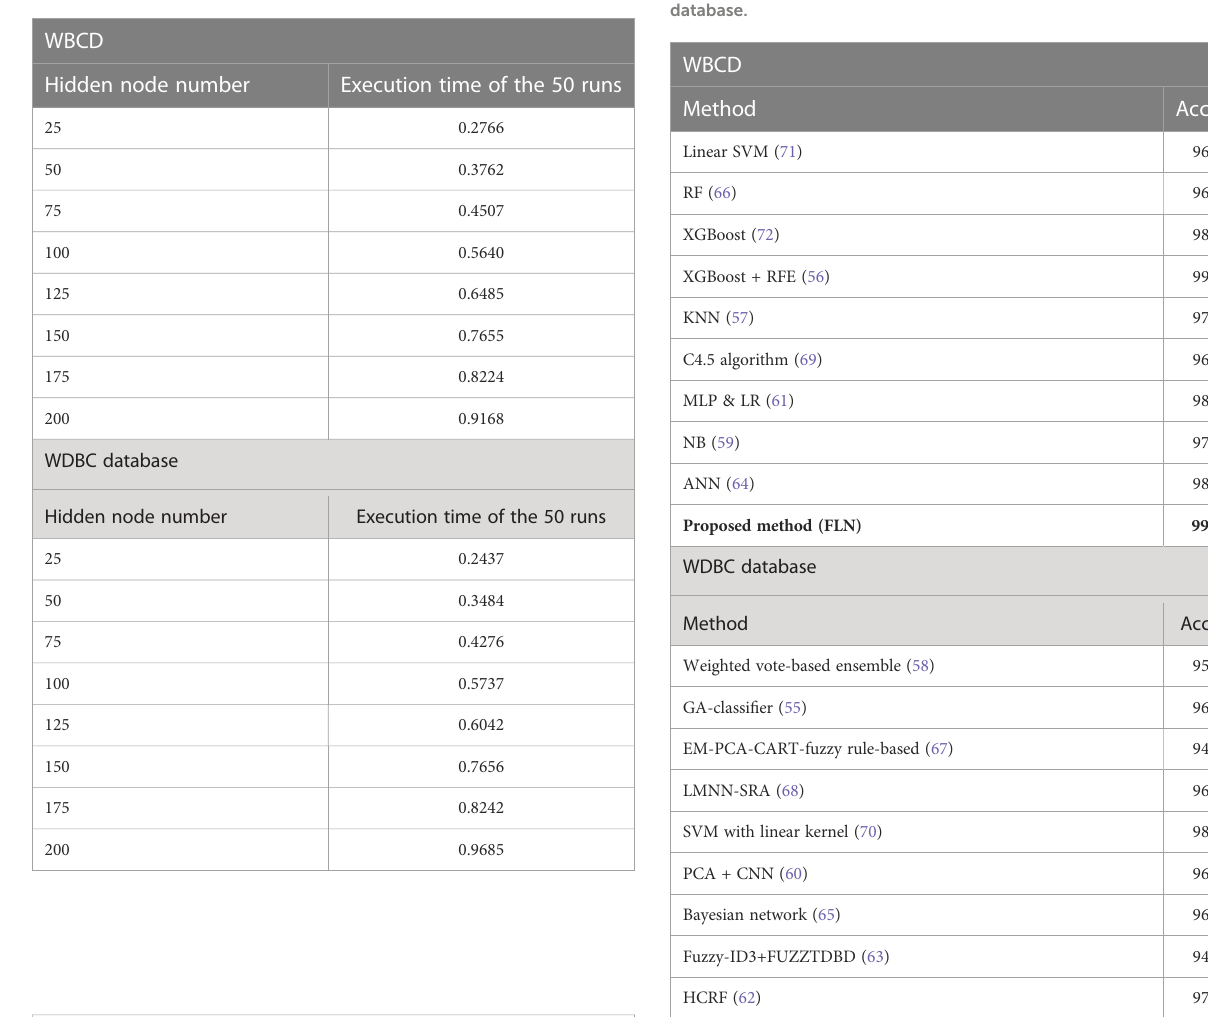
TABLE 9 The total run time for the 50 runs in all experiments of the proposed FLN algorithm using the WBCD and WDBC database.